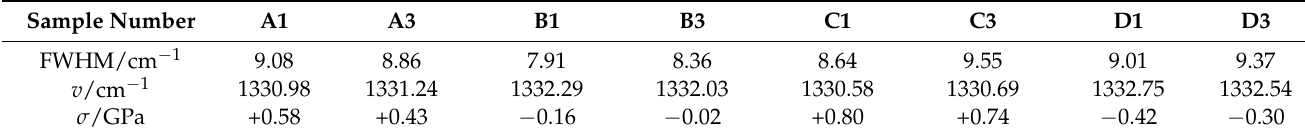
Table 2. Results of the Raman spectra of diamond